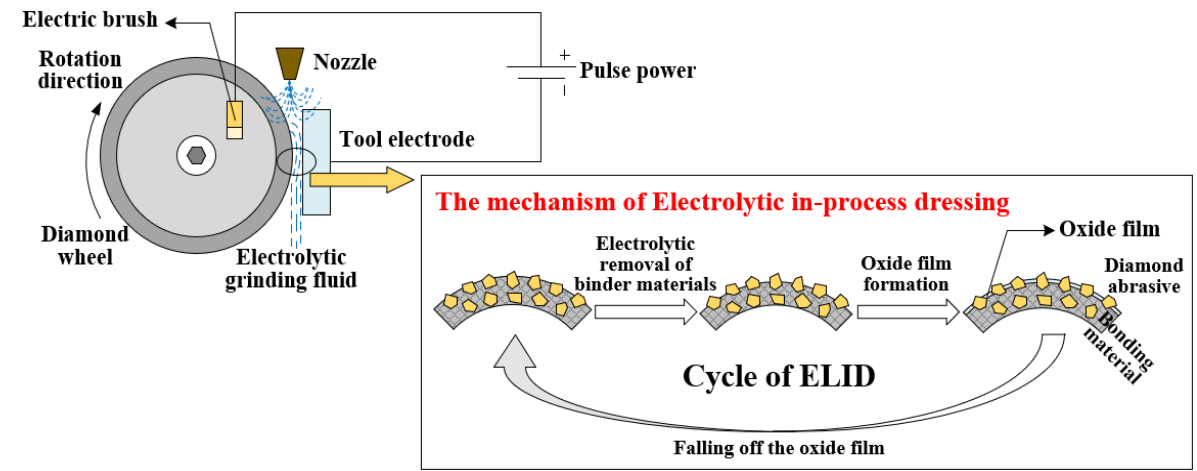
Figure 12. Schematic diagram of electrolytic in-process dressing technology.